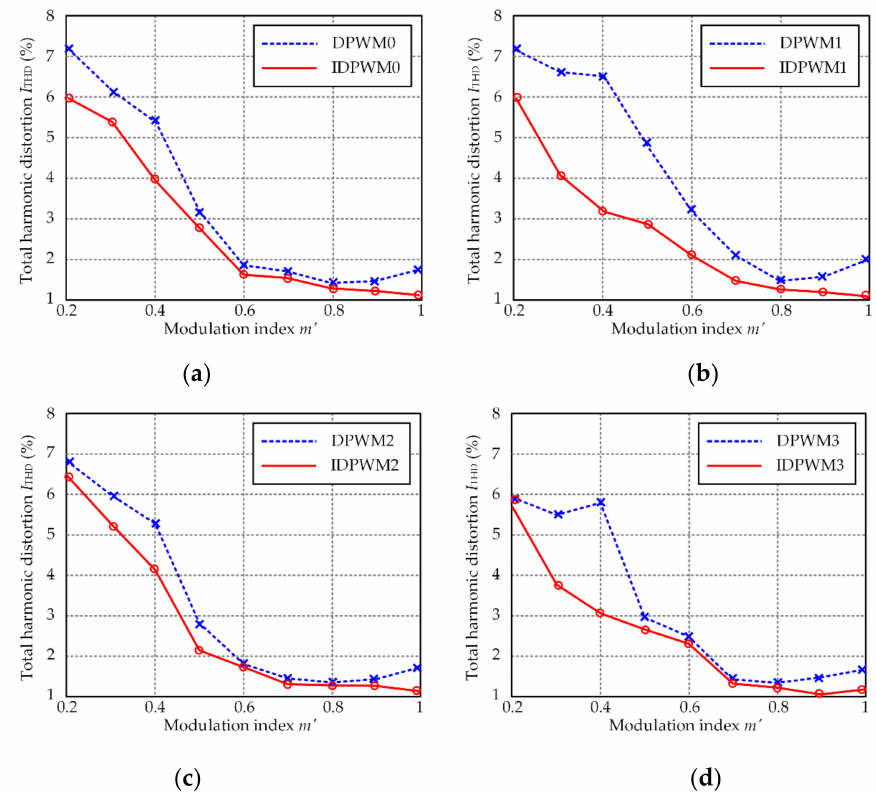
Figure 11. Variations of I THD with the change of m ’ for DPWM0–DPWM3 and IDPWM0–IDPWM3: ( a ) DPWM0 and IDPWM0; ( b ) DPWM1 and IDPWM1; ( c ) DPWM2 and IDPWM2; ( d ) DPWM3 and